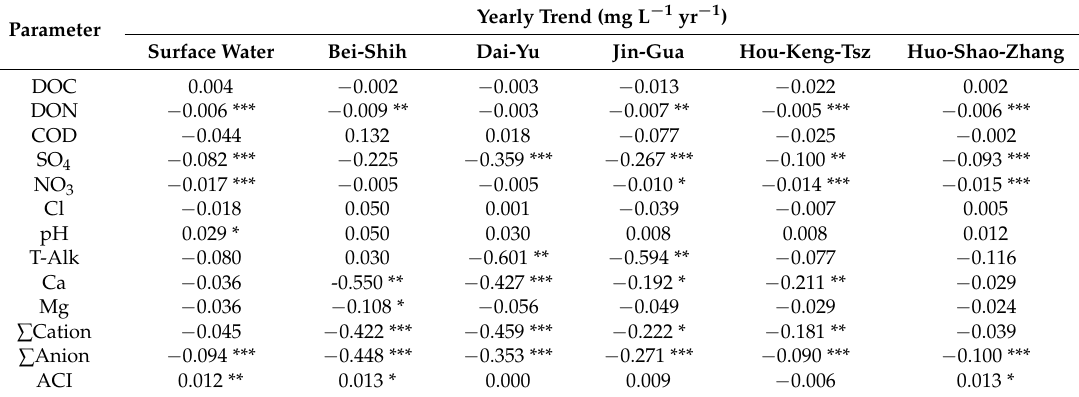
Annual trends of DOC and other constituents in surface water and tributaries of Fei-Tsui